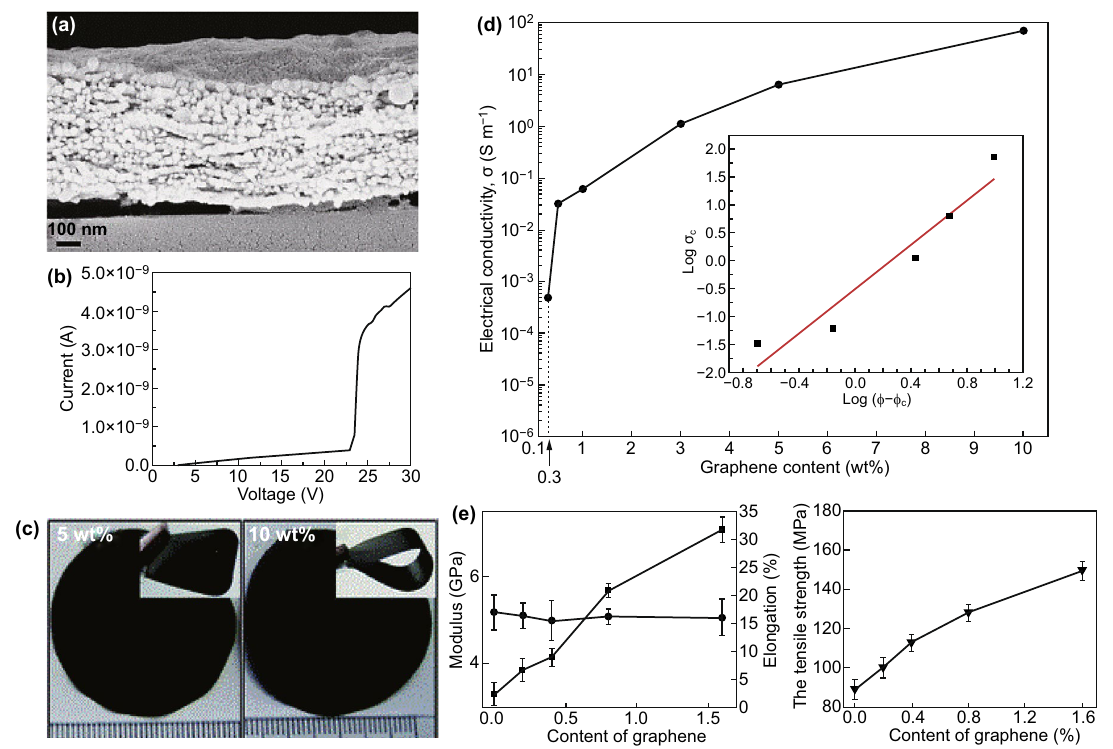
Fig. 10 a CNCs-GO hybrid films morphological image. b The current–voltage curve of CNCs-GO hybrid films. Reproduced with permission from Ref. [133] Copyright © 2013, Elsevier Ltd. c Robust-conductive CNFs-rGO hybrid film. d rGO content influences electrical conductivity. Reproduced with permission from Ref. [30]. Copyright © 2011, The Royal Society of Chemistry. e GO content influences cellulose-GO Young’s modulus and tensile strength. Reproduced with permission from Ref. [38] Copyright © 2011 Elsevier